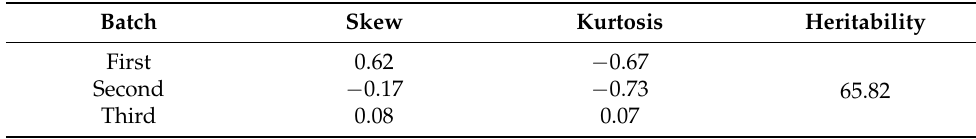
Table 3. Descriptive statistics of G. soja resistance to P. sojae